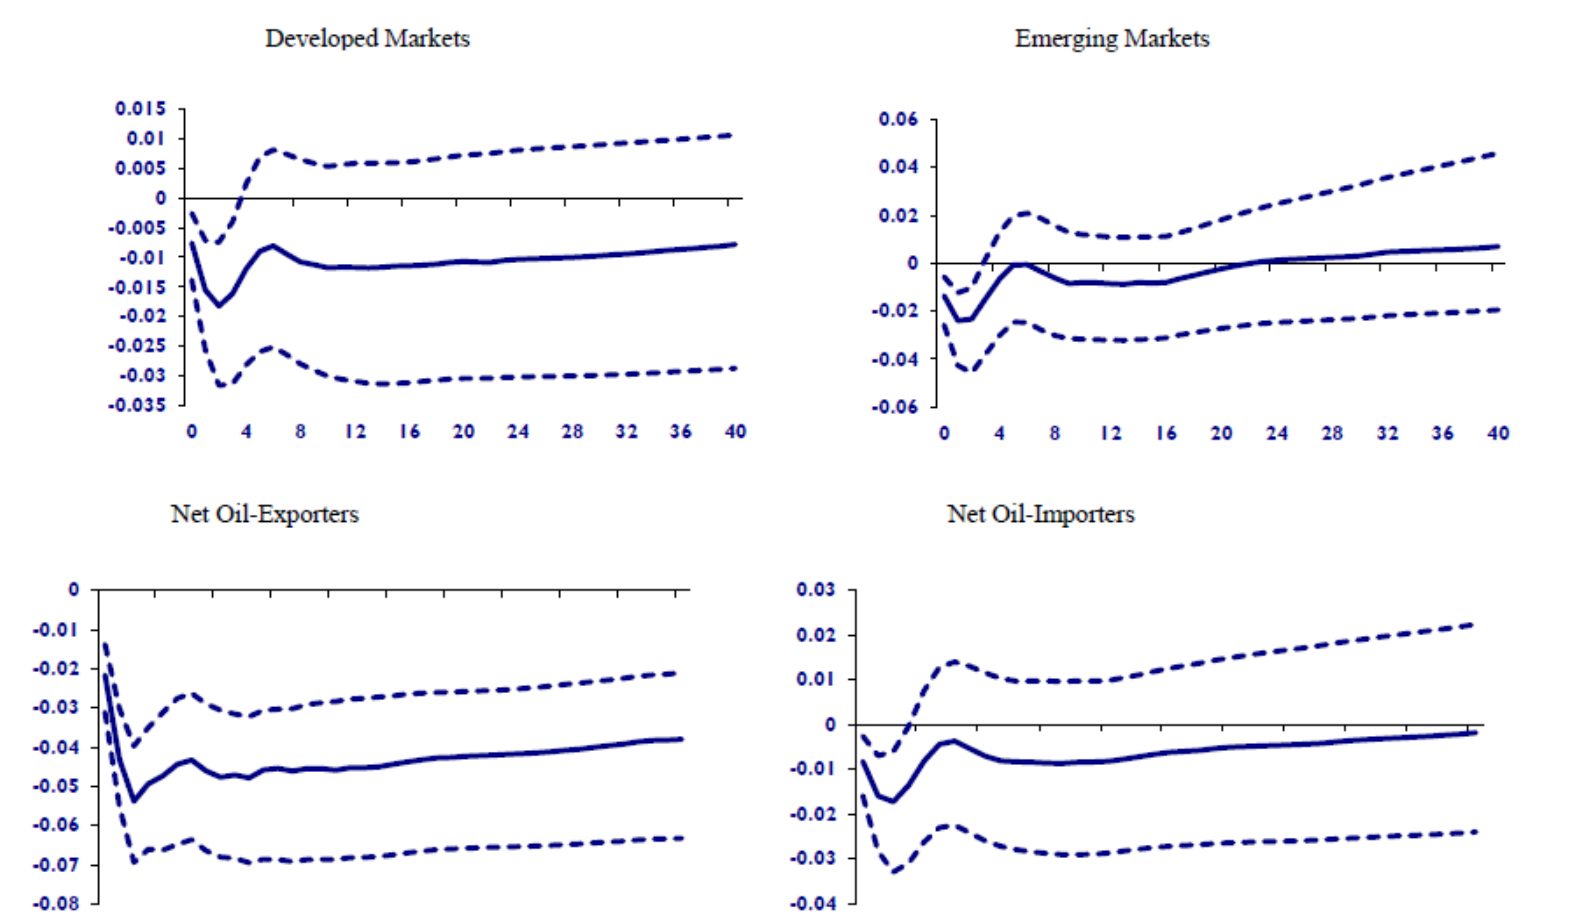
Figure 2. GVAR-based oil price uncertainty shocks and real stock prices ( country groups ). Note: The figure depicts the impulse response functions of real stock prices of country groups to a one standard deviation increase in oil price uncertainty. The median impulse response is presented in solid lines, while the 16–84% lower and upper bootstrapped error bands are shown in dotted lines. The impact is measured in percentage points (by multiplying the estimates in the figure with 100) over the quarterly horizon.